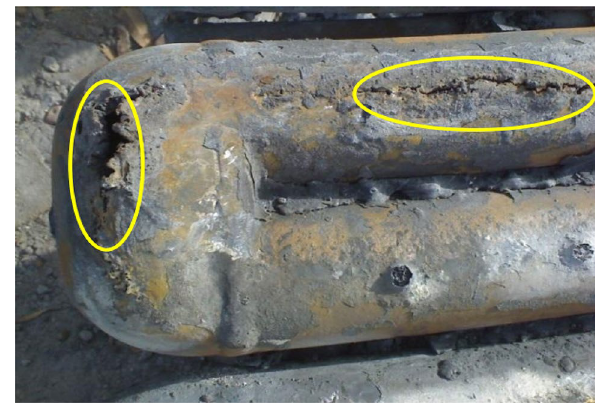
Fig. 12 Mechanical failure locations on WCPs hot-side